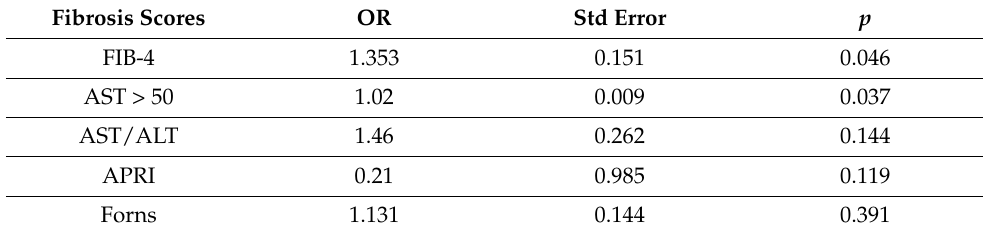
Table 5. Multivariate analysis of fibrosis scores for survival prediction.